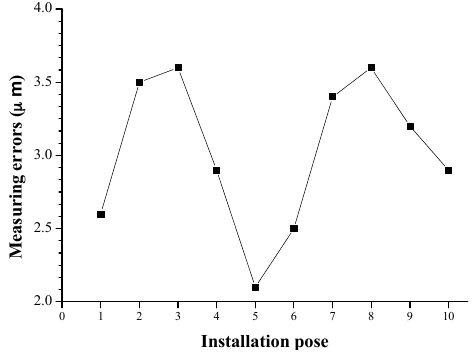
Figure 11. The influence of installation pose.